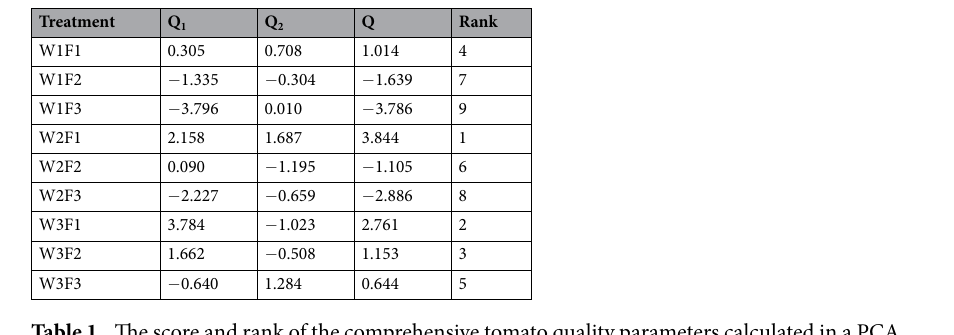
Table 1. The score and rank of the comprehensive tomato quality parameters calculated in a PCA of all the treatments. The treatments are noted as W1, 100% ET 0 ; W2, 75% ET 0 ; W3, 50% ET 0 ;